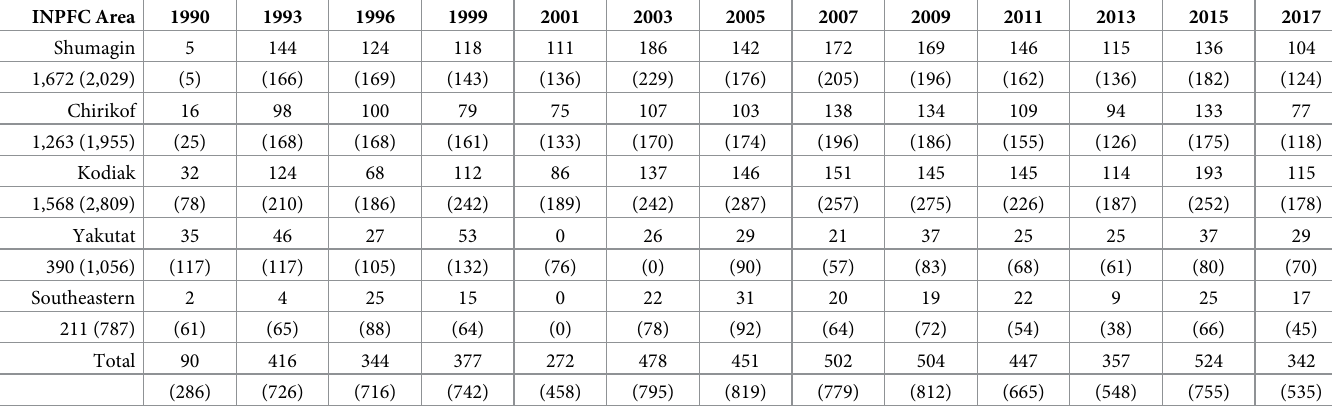
Table 1. Number of tows that captured at least one Pacific Halibut (n = 5,104) measuring 30 to 69 cm fork length. INPFC Area